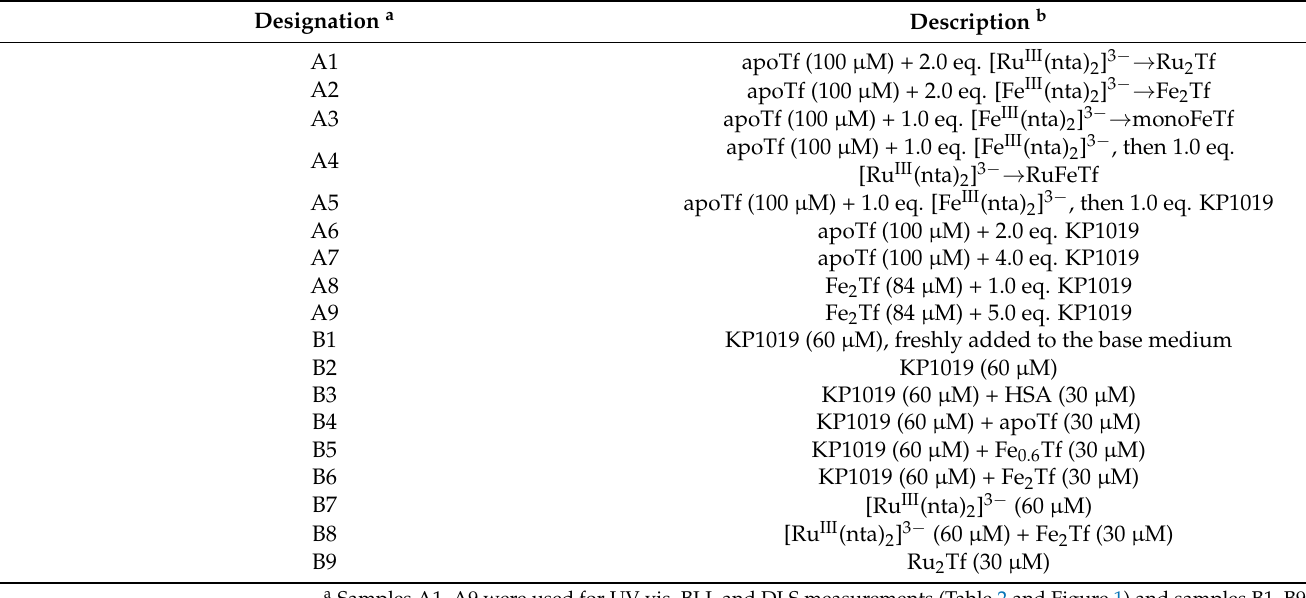
Table 1. Conditions of sample